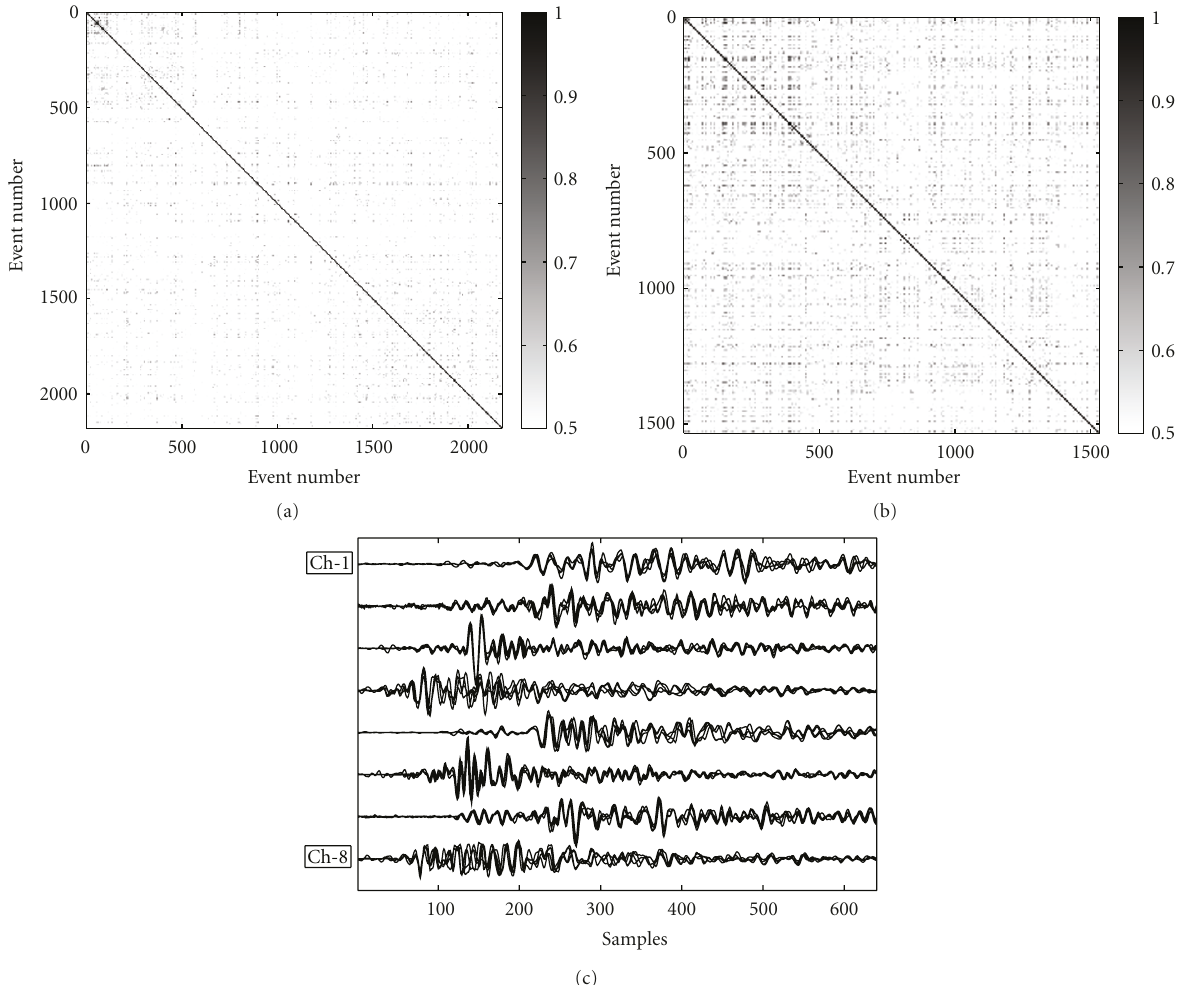
Figure 5: Correlation matrices of (a) SR1 and (b) SR2. (c) Overlap plot of AE events related to a particular cluster with four